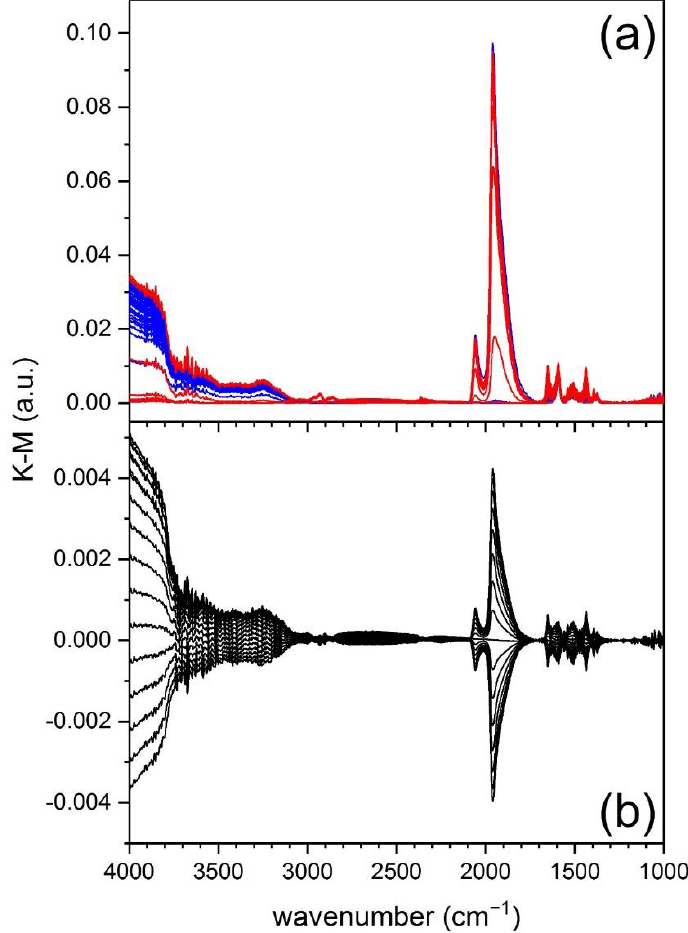
Figure 3. ( a ) Time-resolved spectra and ( b ) phase-resolved DRIFT spectra of 1.0 wt.% Pd/Al 2 O 3 in K-M units corresponding to the data obtained during the O 2 /CO modulation experiment at 300 °C of Figure 2a.